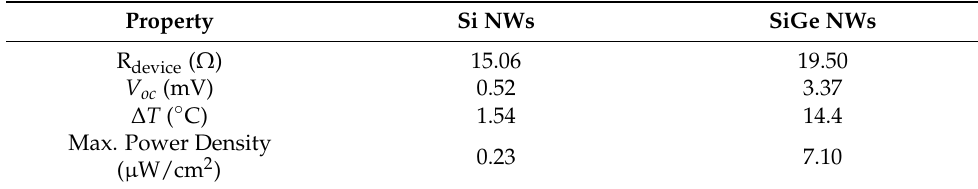
Table 3. Harvesting parameters for three trenches devices populated with Si or SiGe NWs for a hotplate temperature of 200 ◦ C and an effective device area of 2 mm 2 .